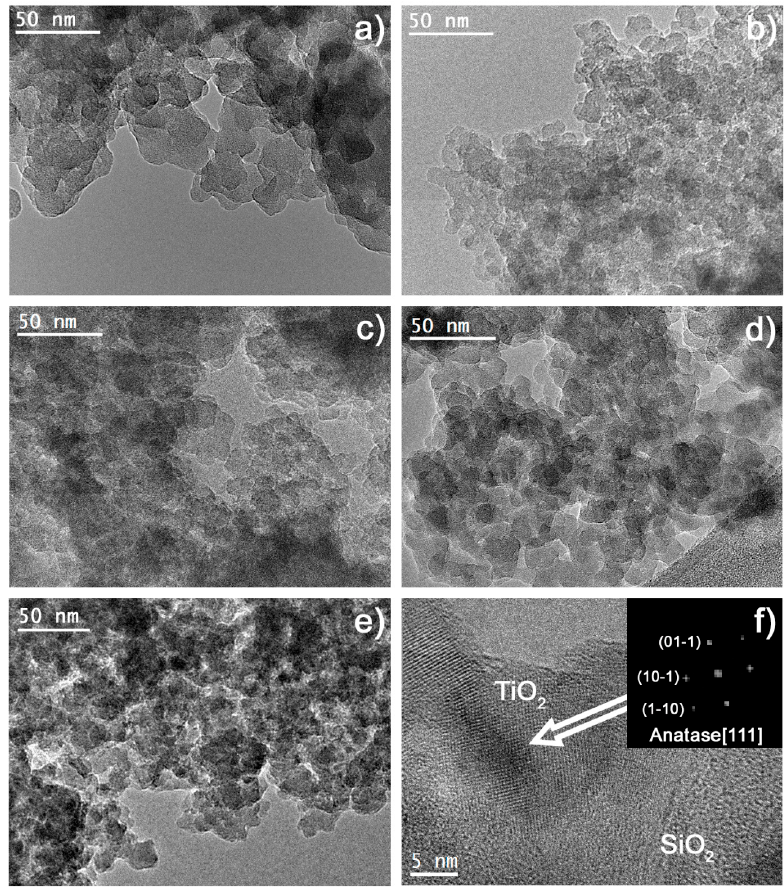
Figure 4. HRTEM images of photocatalysts ( a ) S0Au, ( b ) ST0Au, ( c ) ST5Au, ( d ) ST12Au, ( e ) ST25Au and ( f ) detail of a TiO 2 NP and its digital diffraction pattern.